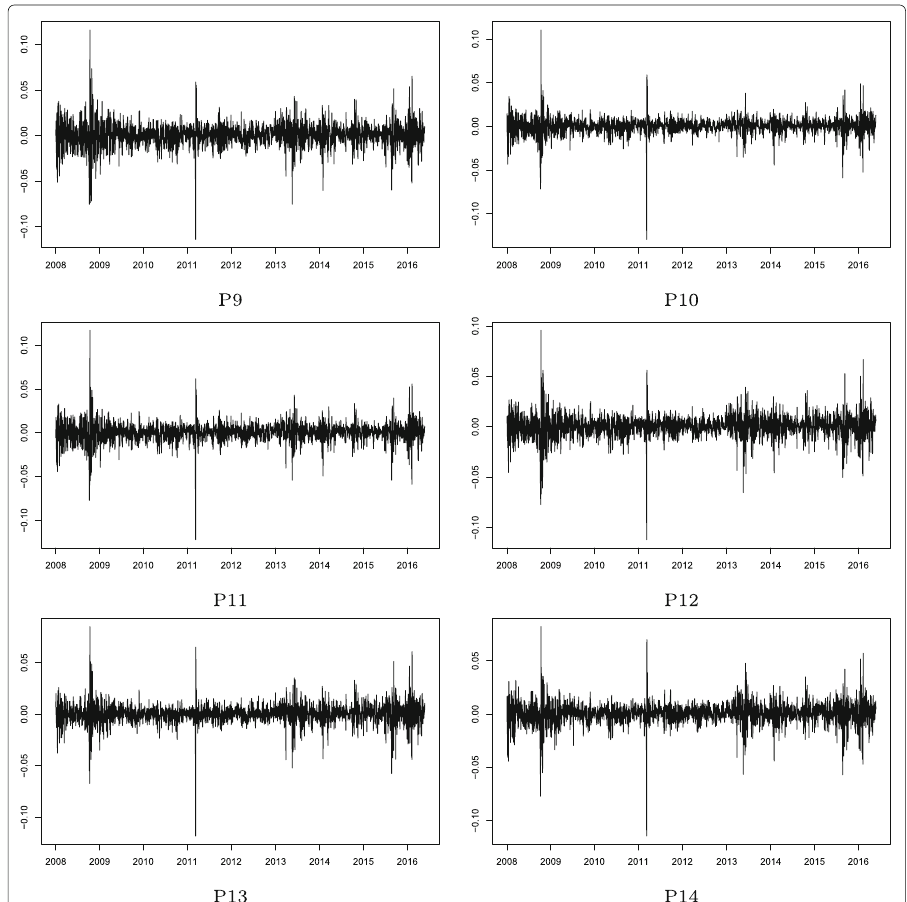
Fig. 5 Stock returns: Defensive group sub-portfolios. Note: The stock return of a sub-portfolio is calculated as the daily log return of the stock price index of the group-based sub-portfolio shown in Fig.